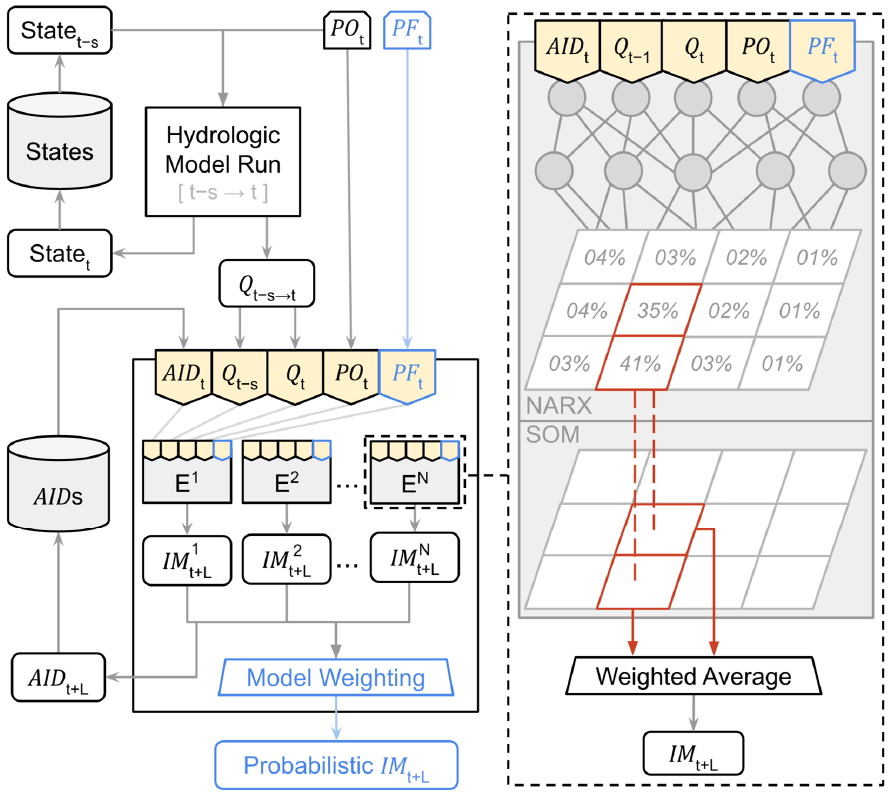
Figure 7. Diagram representing the dataflow of the hypothetical operational setup. E i indicates the i-th member of the ensemble system, comprehended by a hybrid NARX-SOM model (represented within the dashed rectangle). Blue boxes indicate the changes from Zanchetta and Coulibaly [19]. Number of inputs, neurons, and topological nodes are hypothetical and for illustrative purposes